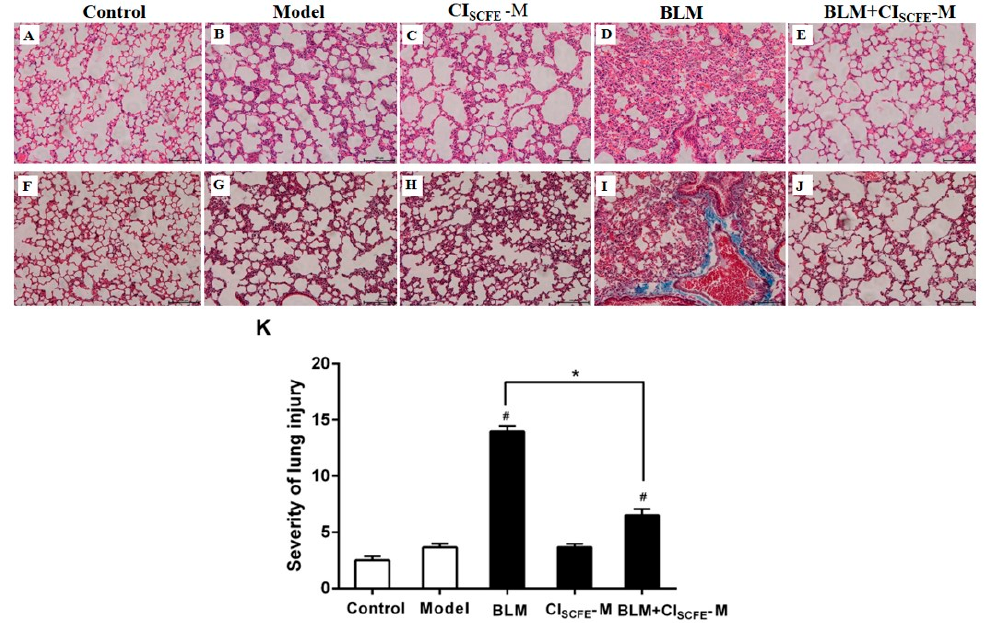
Figure 5. Effect of CI SCFE attenuated BLM-induced lung fibrosis. Lung tissue sections were stained with haematoxylin-eosin (H&E) ( A – E ) for pathological examination (200×); Masson ( F – J ) for collagen deposition (200×); ( K ) severity scores of lung injury. The slides were histopathologically evaluated using a semiquantitative scoring method. The total lung injury score was estimated by adding up the individual scores of each category. Scale bar indicates 100 μ m. Data are expressed as mean ± SEM ( n = 8). # p < 0.05 vs. model group; * p < 0.05 vs. BLM group.